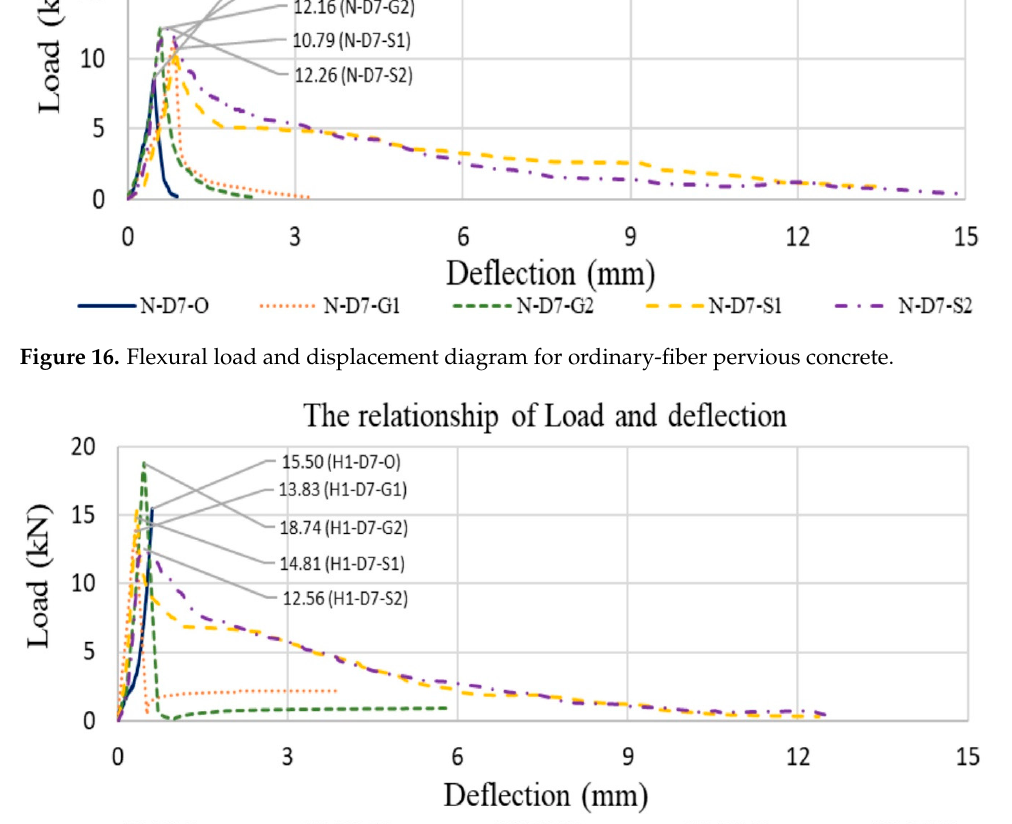
Figure 18. Flexural load and displacement diagram for H1.2 high-strength fiber pervious concrete. Table 6. Flexural toughness and toughness factor for fiber pervious concrete. Pervious Concrete